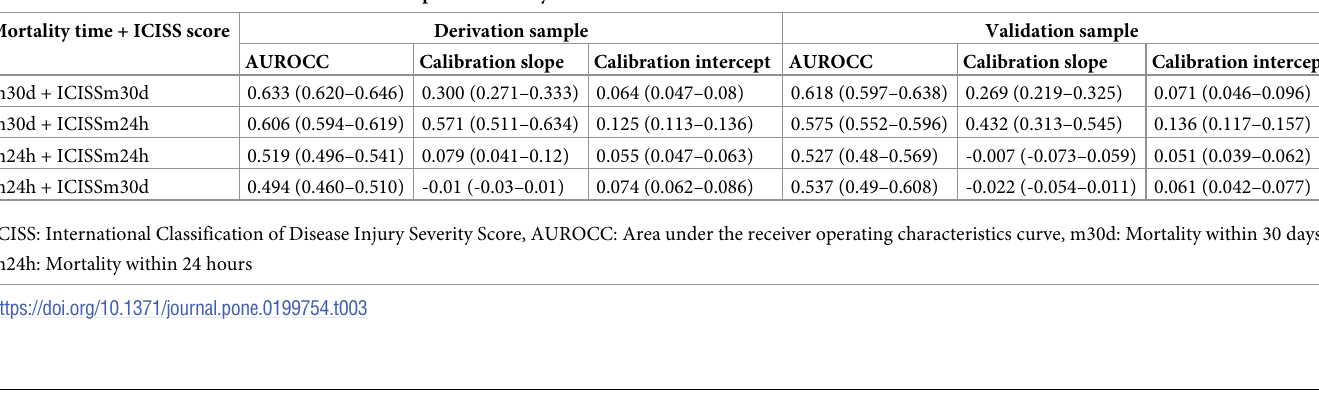
Table 3. Discrimination and calibration for the complete case analysis.